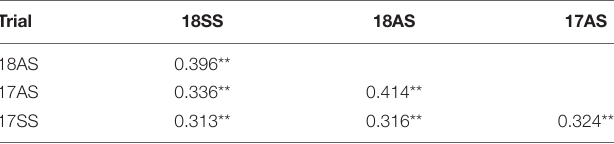
TABLE 3 | Correlation coefficients for Cd content among four